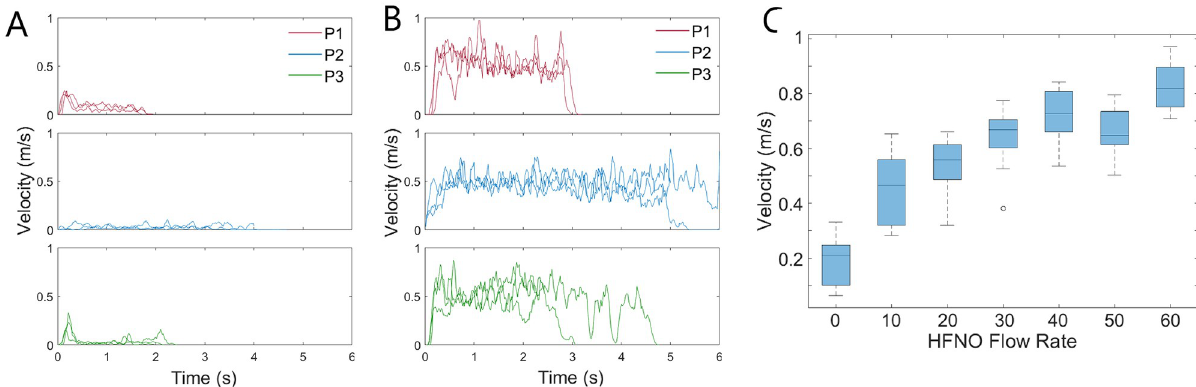
Fig 4. Schlieren breathing trials. Velocity during a single breathing cycle for (A) unassisted breathing and (B) HFNO at 60 L/min for each participant. (C) Range of maximum breathing velocities for all participants. Box and whisker plots show median and interquartile ranges for the data set.